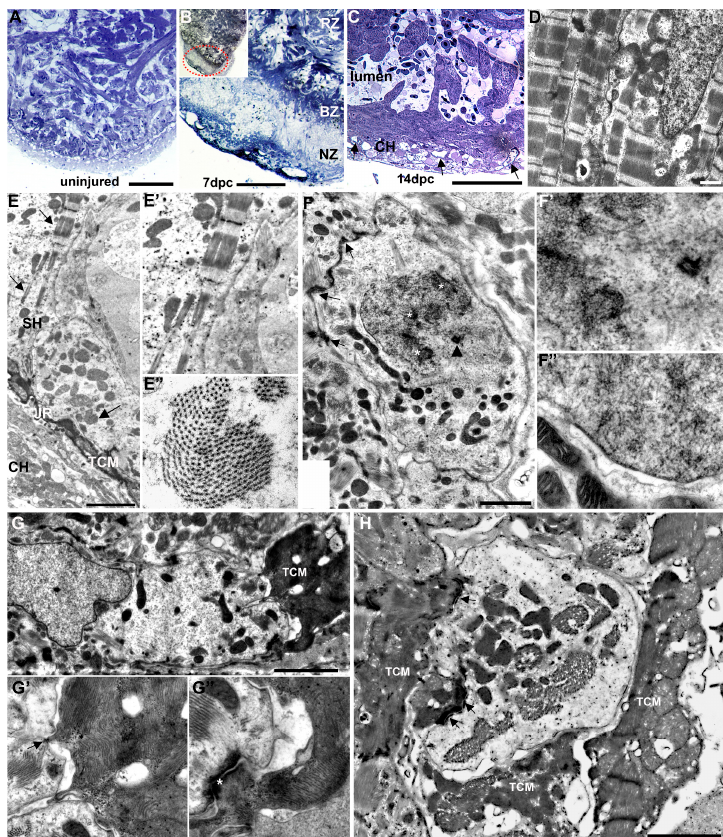
Figure 3. Ultrastructural characterization of the cauterized heart. ( A ) Toluidine-stained section of an uninjured zebrafish heart. ( B ) Section of a cauterized ventricle (inset) at 7 days post-cautery (dpc) showing the apical necrotic zone (NZ), the remote basal zone (RZ), and the border zone (BZ) intercalated between the two at higher magnification. The section shows a reduction in stain intensity in the cauterized apical region consistent with the loss of sarcomeric myocardial structure. ( C ) Regenerated region 14 dpc showing compact myocardium with numerous coronary vessel profiles (arrows) in the compact heart (CH) and myocardial trabeculae projecting into the ventricular lumen. ( D ) TEM of well-organized and sarcomere-rich cardiac myocytes in the basal region remote to the injury. ( E ) TEM 14 dpc of the junctional region (JR) at the interface between the compact heart (CH) and spongy heart (SH) with an electron-dense transitional cardiac myocytes (TCMs). Sparse sarcomeres (arrows) with various levels of organization can be seen in the trabecular cardiac myocytes of the spongy heart. The compact heart appears less organized. Higher magnification of longitudinally sectioned sarcomeres ( E’ ), and cross-sectioned sarcomeres ( E” ) in trabecular myocytes in ( E ). ( F ) A mitotic cardiac myocyte profile with sparse and poorly organized sarcomeric structures compared to adjacent myocytes. The mitotic myocyte contains numerous mitochondria and is attached to adjacent myocytes by intercalated discs and adherens junctions (arrows). Decondensing chromosomes (asterisk) and an incompletely formed nuclear envelope can be observed as well as a peri-nuclear centriole (arrowhead). ( F (cid:48) ) Higher magnification of ( F ) showing decondensing chromosomes, incomplete nuclear envelope, and the perinuclear centriole. ( F” ) Higher magnification of mitotic nucleus with a zone of reconstructed nuclear envelope and adjacent mitochondria. ( G ) Interaction between an electron-dense transitional cardiac myocyte and an adjacent electron-lucent trabecular myocyte with minimal sarcomeric structure at the junctional region. ( G (cid:48) ) Higher magnification showing connection of the two cells via desmosomes (arrow), and ( G” ) coupling through an intercalated disk (asterisk). ( H ) Reorganized pattern of the junctional region showing an electron-lucent cardiac myocyte (center) with sparse sarcomeric structures surrounded by and intercalated (arrow) with multiple electron-dense transitional cardiac myocytes (TEM). Scale bars: A – C = 100 µ m, D = 1 µ m, E = 10 µ m, F – G = 2 µ m, H = 1 µ